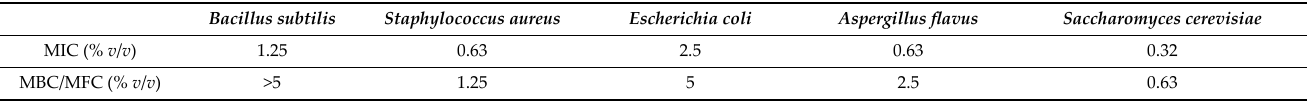
Table 3. Minimum Inhibitory Concentrations (MICs), Minimum Bactericidal Concentrations (MBCs), and Minimum Fungicidal Concentrations (MFCs) of Allium tenuissimum L. flowers essential